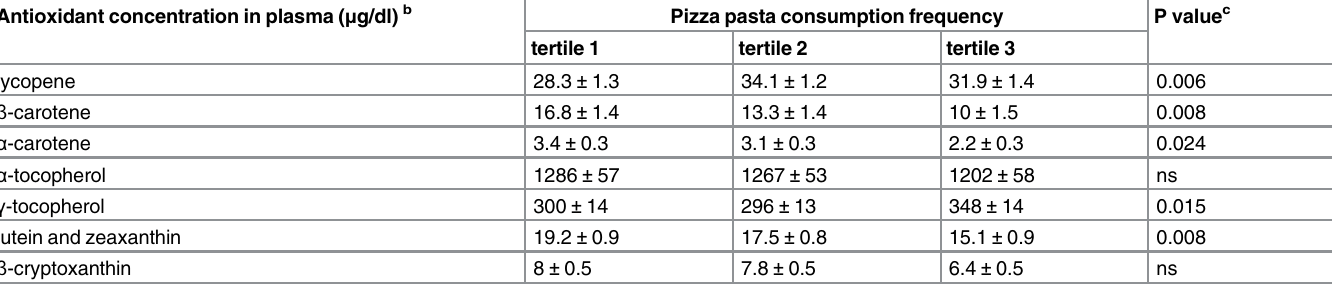
Table 3. Plasma concentration of antioxidant nutrients across the pizza and pasta consumption frequency tertiles (n = 369) a . Antioxidant concentration in plasma ( μ g/dl) b